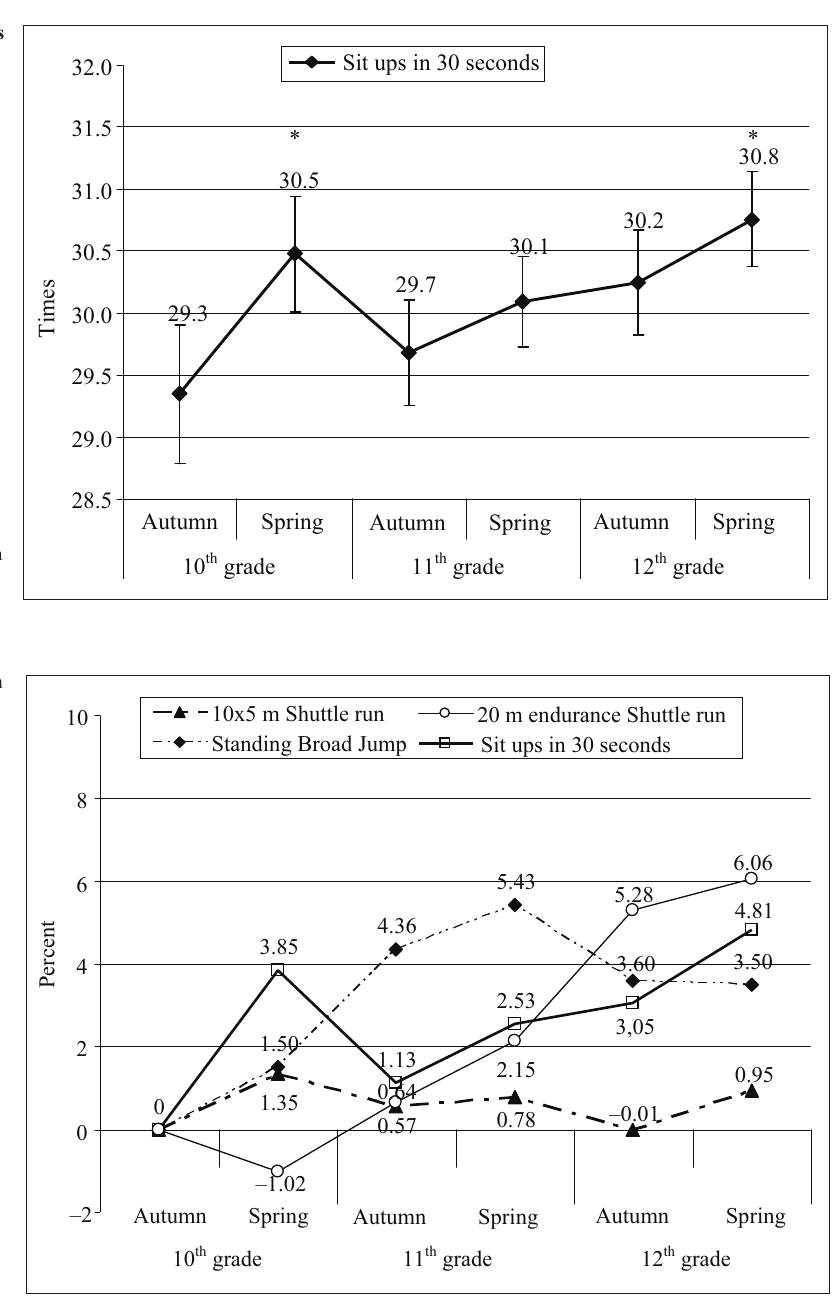
Figure 4. Comparison of changes in results in percent